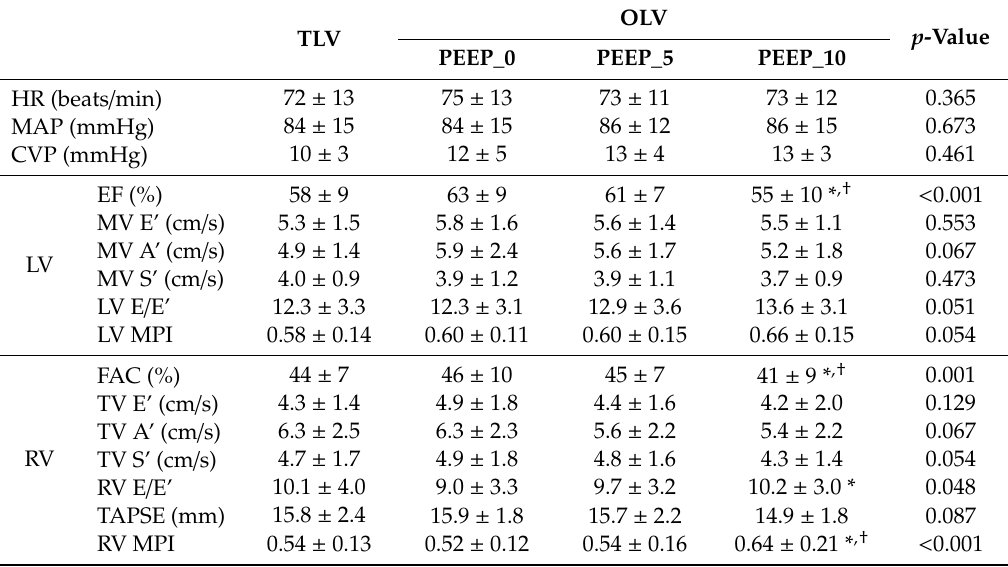
Table 3. Hemodynamic and echocardiographic parameters during two-lung ventilation (TLV) and one-lung ventilation (OLV) at di ff erent levels of positive end-expiratory pressure (PEEP). OLV TLV HR (beats / min) MAP